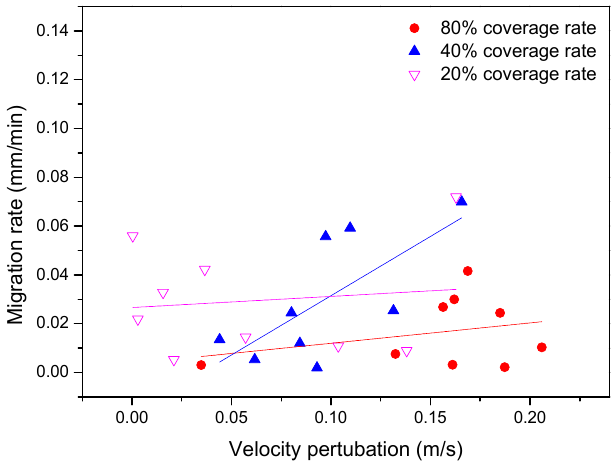
Figure 12. Migration rate versus velocity perturbation, 80–960 min.